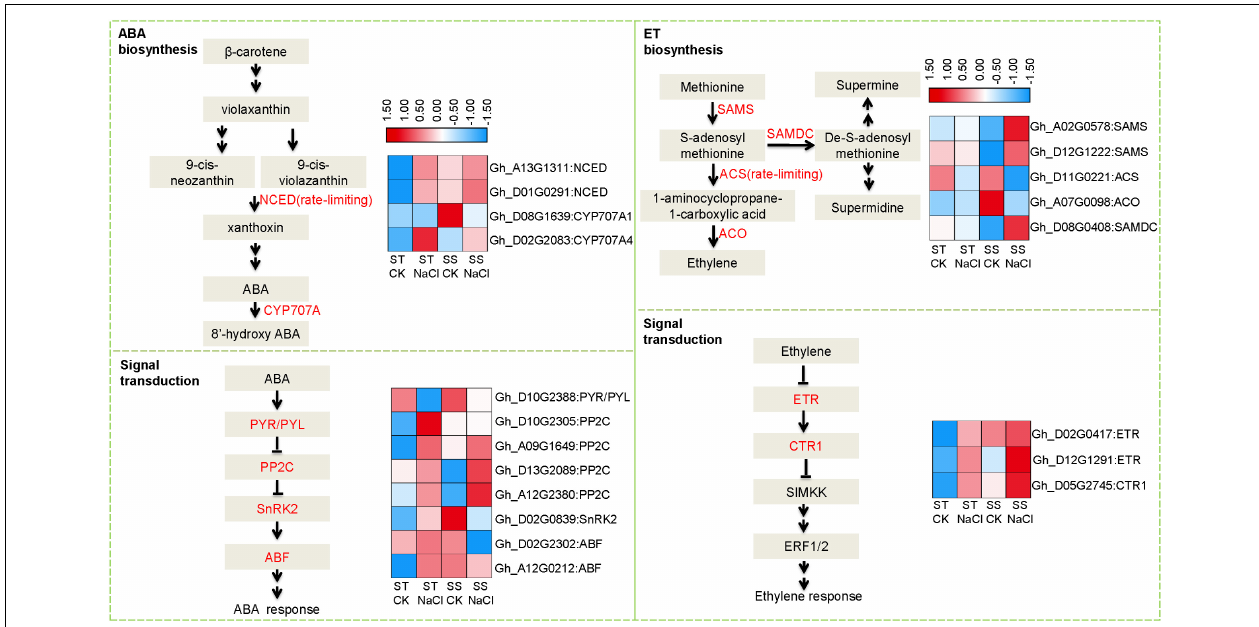
FIGURE 4 | Differentially expressed genes involved in abscisic acid (ABA) and ethylene (ET) biosynthesis and signal transduction. Fragments Per Kilobase of transcript sequence per Millions base pairs sequenced (FPKM) values of related DEGs represented as a color gradient from low (blue) to high (red).